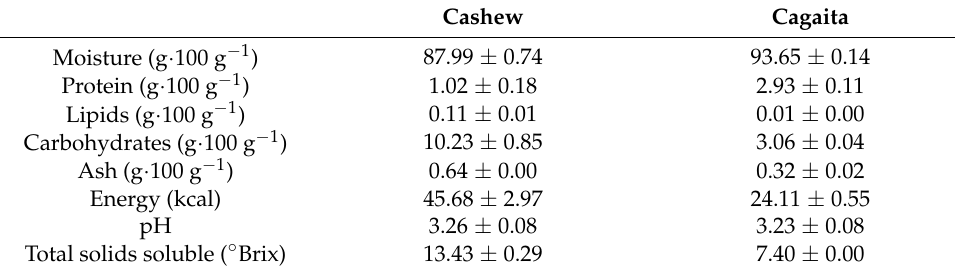
Table 1. Chemical composition of “Cerrado” cashew and cagaita